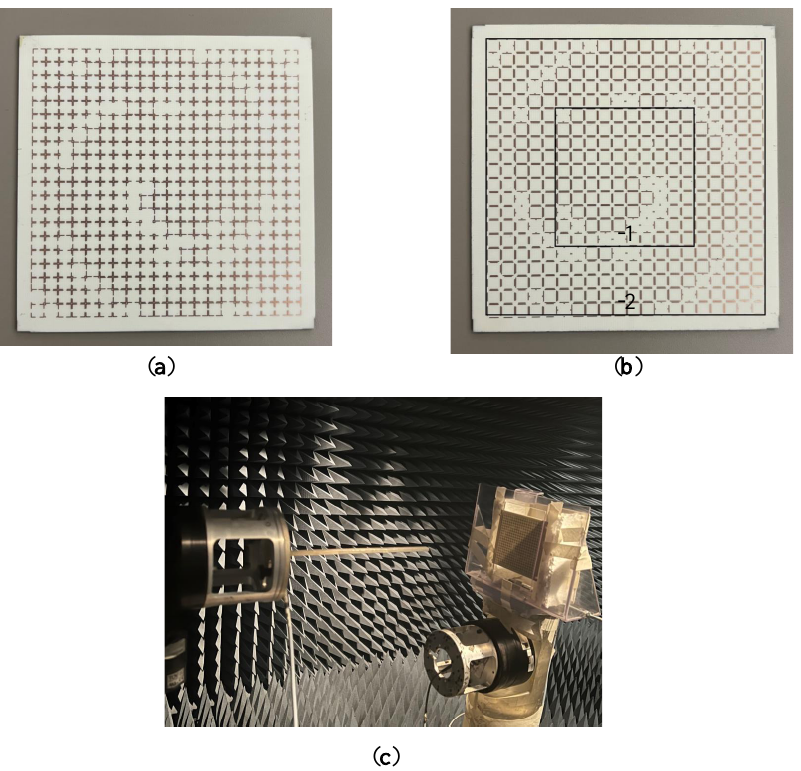
Figure 4. Configuration of the fabricated structure: ( a ) front side, and ( b ) back side.